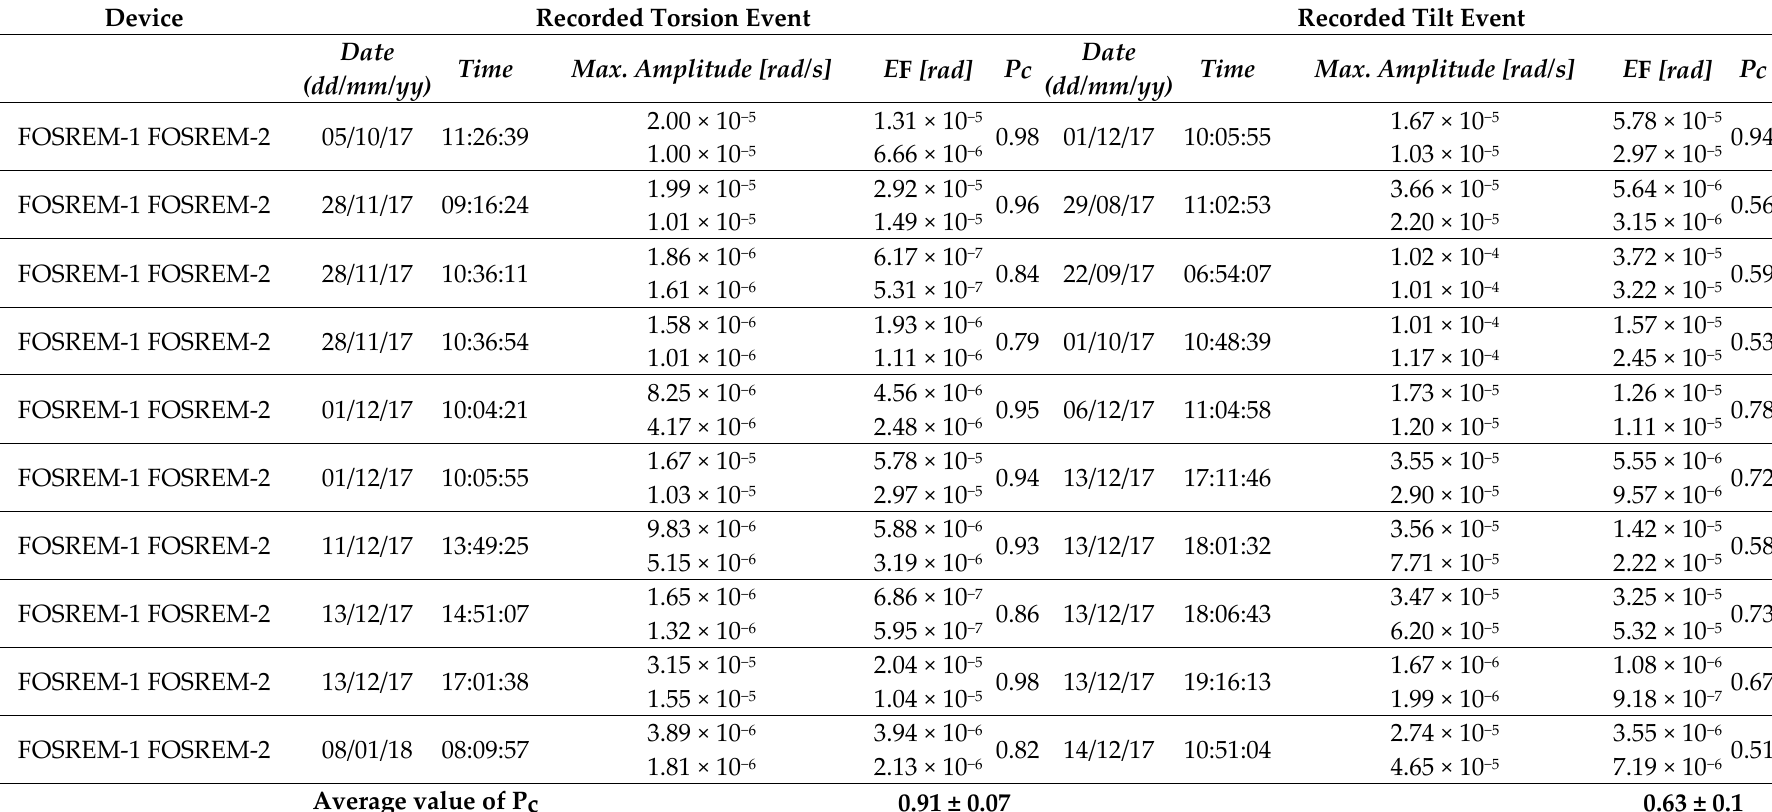
Table 1. Data recorded by the FOSREMs in the geophysical observatory in Ksi ąż ,